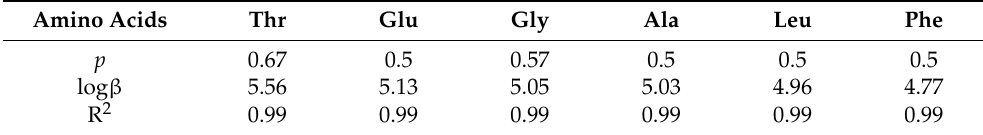
Figure 6. Fitted curves of ( a ) Thr, ( b ) Glu, ( c ) Gly, ( d ) Leu, ( e ) Ala, and ( f ) Phe with Cd 2+. Table 5. Calculated complex parameters of the studied amino acids with Cd 2+ .